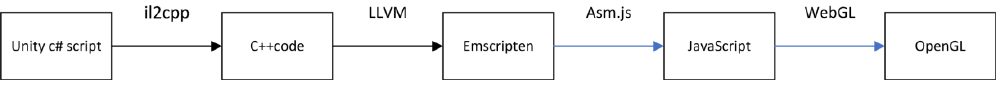
Figure 1. The Unity3d package WebGL compilation principle.